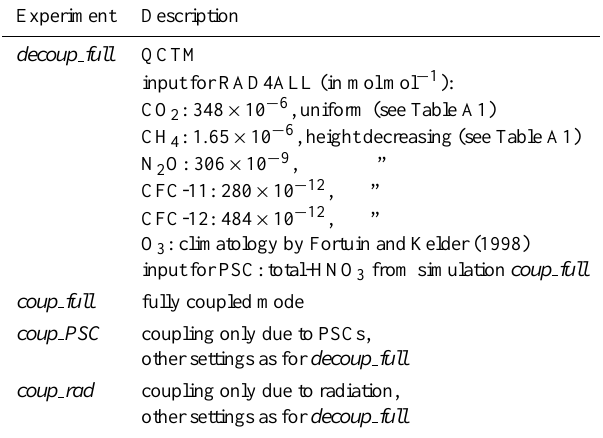
Table 1. Simulations for the QCTM evaluation. All simulations cover the five-year period 1999–2003. Each experiment is con- ducted with the tropospheric dynamics nudged towards ECMWF operational-analysis fields for the period 1999–2003. These fields are pre-processed to generate the nudging data for divergence, vor- ticity, temperature, and surface pressure. The nudging forces the simulations to produce a similar sequence of variability, which is necessary due to the presence of feedbacks between chemistry dynamics in the simulations coup full , coup PSC , and coup rad . The nudging reduces the noise in the simulation inter-comparisons and makes these better fulfill the normality assumption inherent to the paired t-test (Fomichev et al., 2007). Mixing ratios of to- tal HNO 3 from coup full are averaged on a monthly basis be- fore fed into decoup full and coup rad . The setup for all simula- tions is: T42L90MA with EVAL chemistry (J¨ockel et al., 2006), submodels CLOUD, CONVECT, CVTRANS, DRYDEP, H2O, HETCHEM, JVAL, LNOX, MECCA1, OFFLEM, ONLEM, PSC, QBO, RAD4ALL, SCAV, TIMEPOS, TNUDGE, and